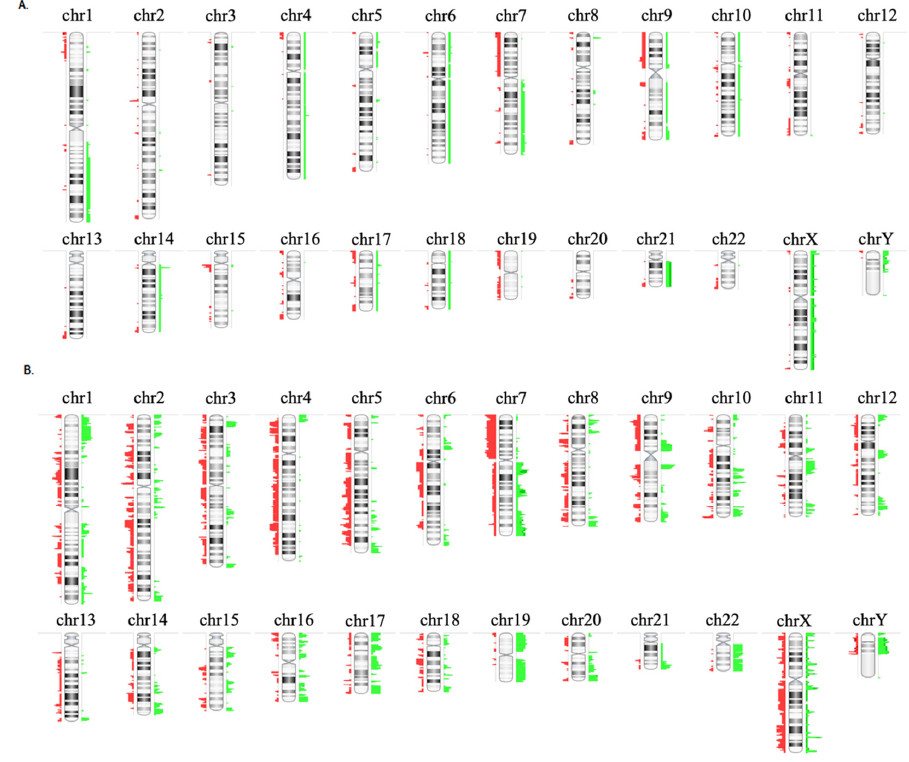
Figure 2. Copy number alterations observed in 13 paired diagnostic/relapse samples. ( A ) CNAs observed in all samples at diagnosis, ( B ) CNAs observed in all samples at relapse. To the right of each chromosome the regions with gains are shown in green and to the left the regions with losses are shown in red.